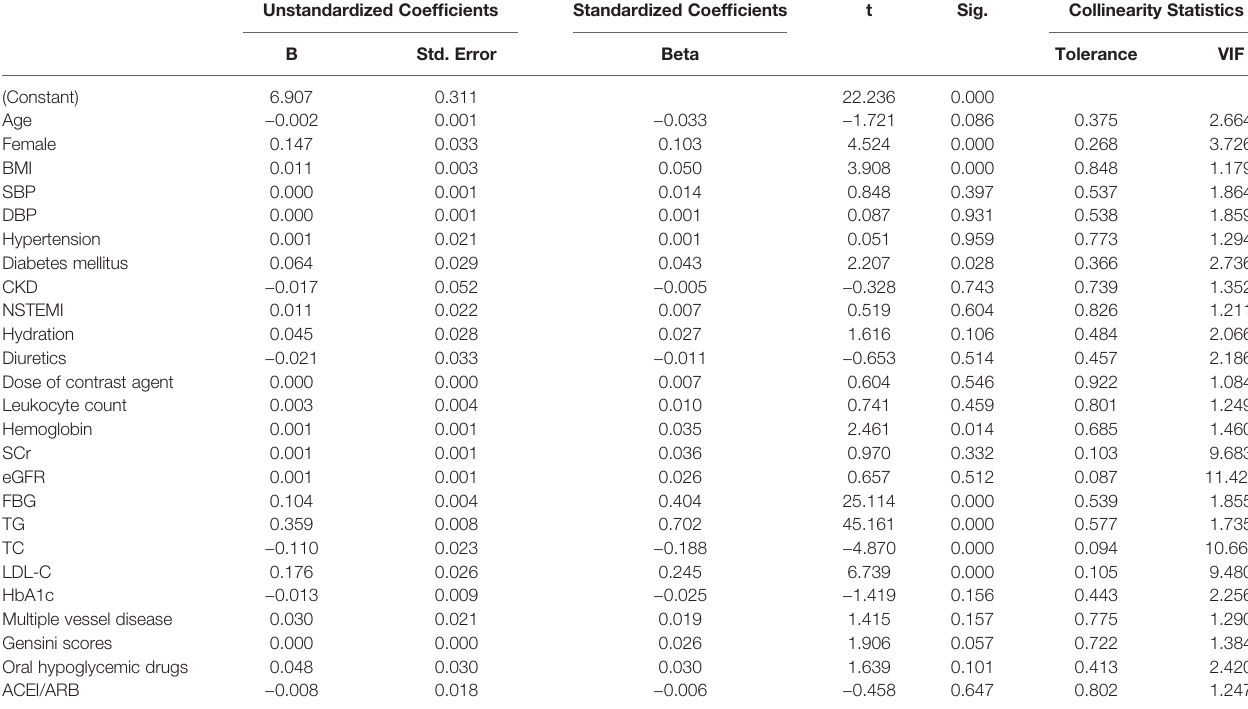
TABLE 3 | Collinearity analysis of baseline data with TyG index.